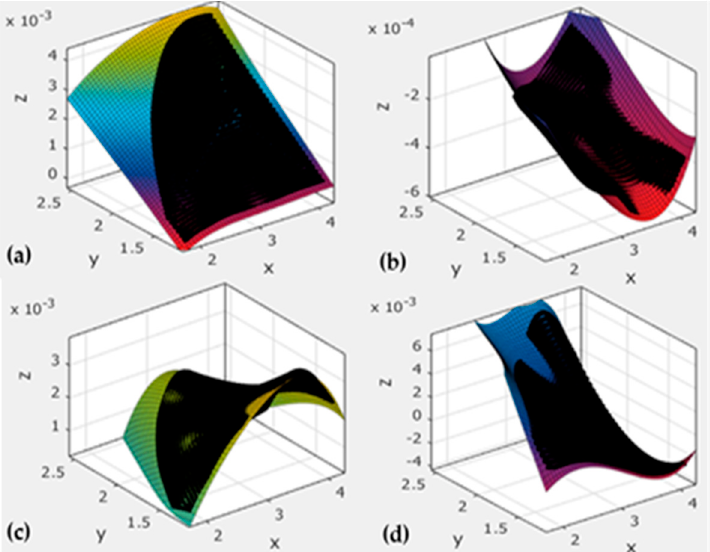
Figure 4. Fitting surface that is bending or torsional of the lower left plate: ( a ) is the first order mode shape that is bending; ( b ) is the fifth order mode shape that is bending and torsional; ( c ) is the sixth order mode shape that is bending; ( d ) is the tenth order mode shape that is bending and torsional.